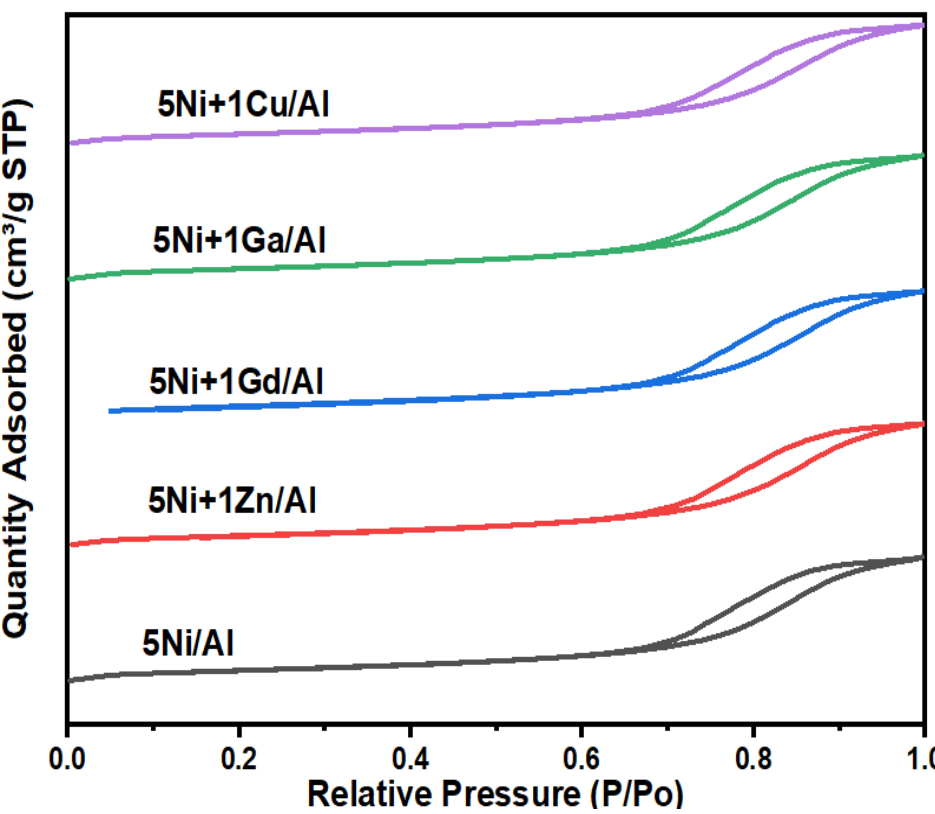
Figure 1. N 2 adsorption-desorption isotherms for non-promoted and promoted catalysts.